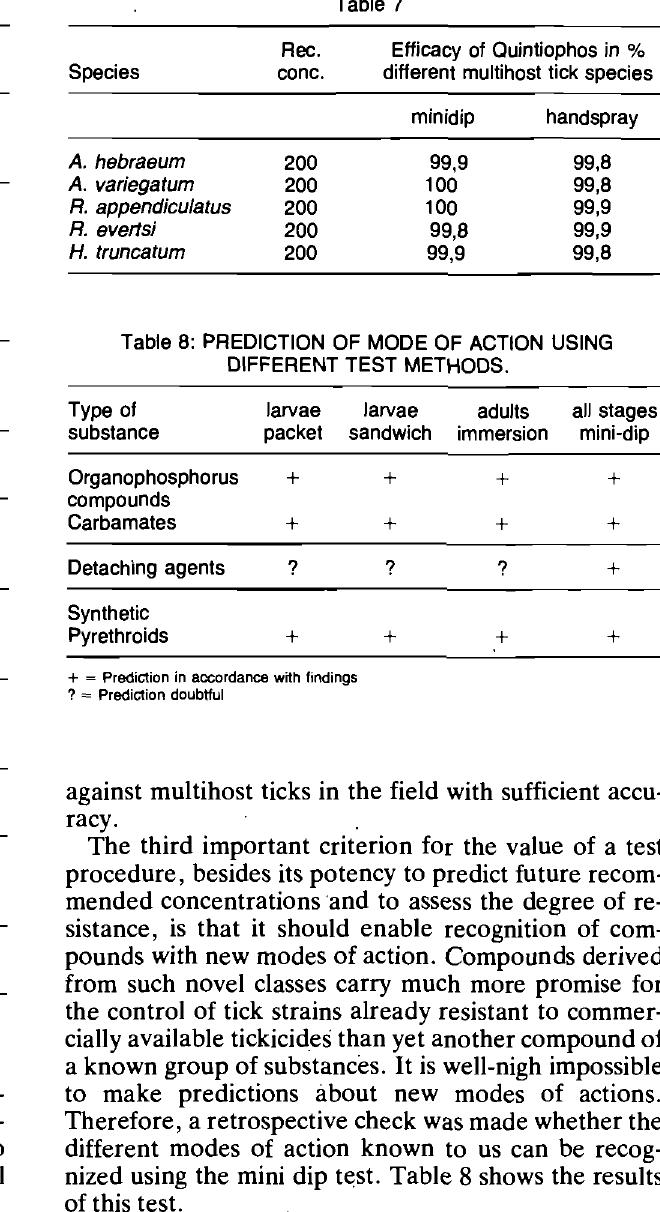
Efficacy in % Boophilus microplus Sens Biarra- Res. Glaston- Str.